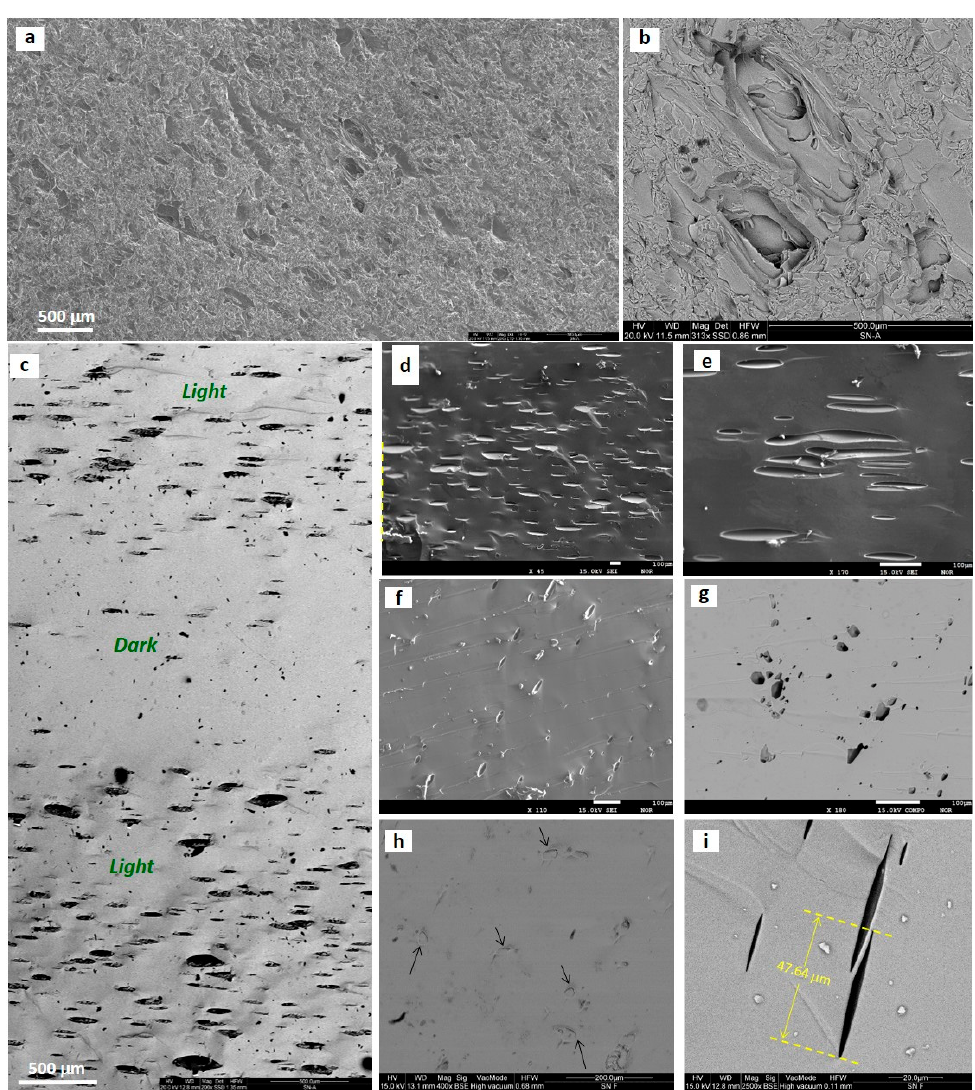
Figure 4. SEM images of the analyzed samples. ( a ) Sample SN-A, secondary electrons (SE) image in which the rough surface with several flat vesicles is visible; ( b ) sample SN-A (SE image), detail of one of the “multilayer” flat vesicles; ( c ) sample SN-B, back-scattered electron (BSE) image. Panoramic view showing the alternation of highly vesiculated bands, corresponding to the light green zones in the macroscopic sample, and non-vesiculated bands, corresponding to dark green, smooth zones; ( d ) sample SN-B, SE image. Detail of the iso-oriented elliptical vesicles of different size in one of the highly vesiculated bands; ( e ) sample SN-B, SE image. Plastically deformed, elongated vesicles; ( f ) sample SN-D, SE image. Iso-oriented elliptical vesicles concentrated in thin bands corresponding to the light green stripes of the macroscopic sample; ( g ) sample SN-E, BSE image. Rare zone of the sample’s surface with sparse vesicles with irregular shape; ( h ) sample SN-F, BSE image. Very flat, irregular vesicles on the green surface with golden hue; ( i ) sample SN-F, BSE image. Dark surface orthogonal to the natural fracture surface. In this direction, the shape of the vesicles is highly elongated and most of the vesicles are